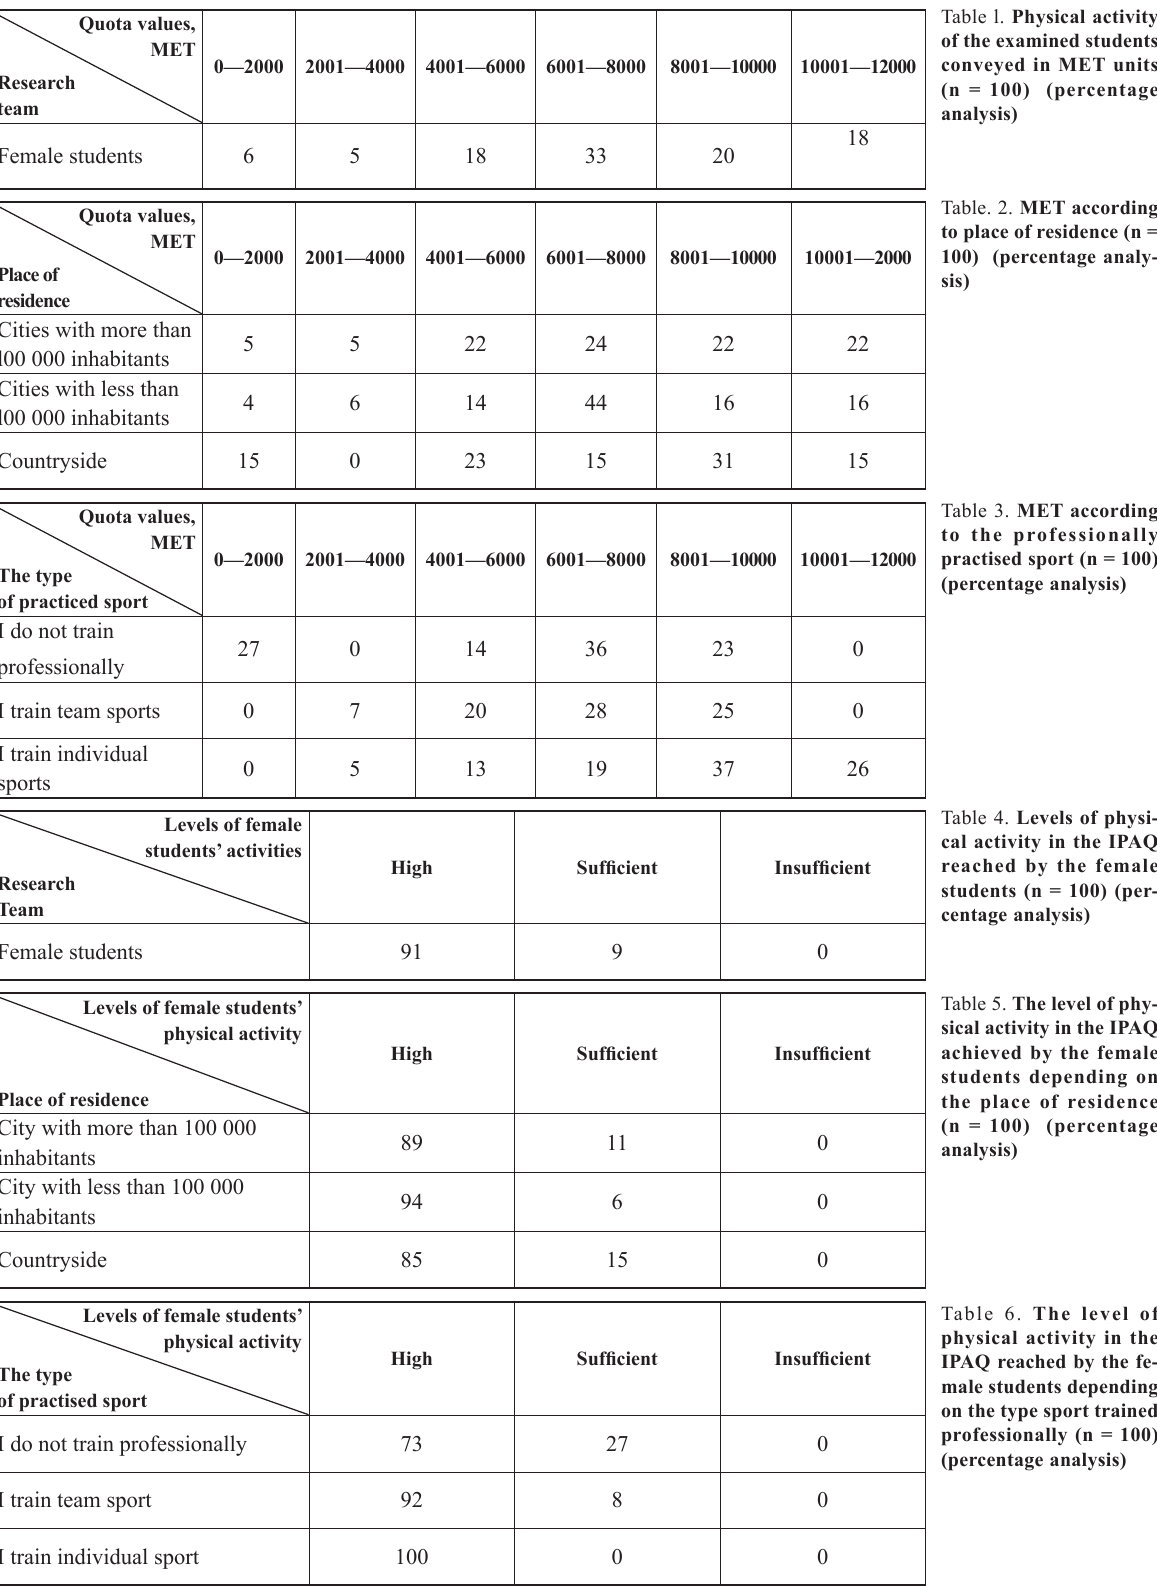
Table l. Physical activity of the examined students